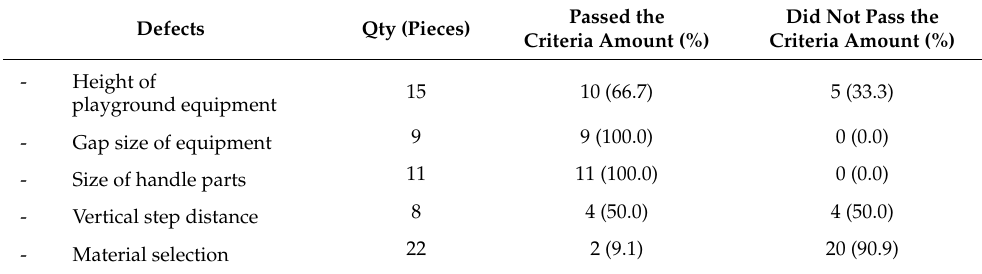
Table 1. Playground safety at a park in Nakhon Si Thammarat Province,